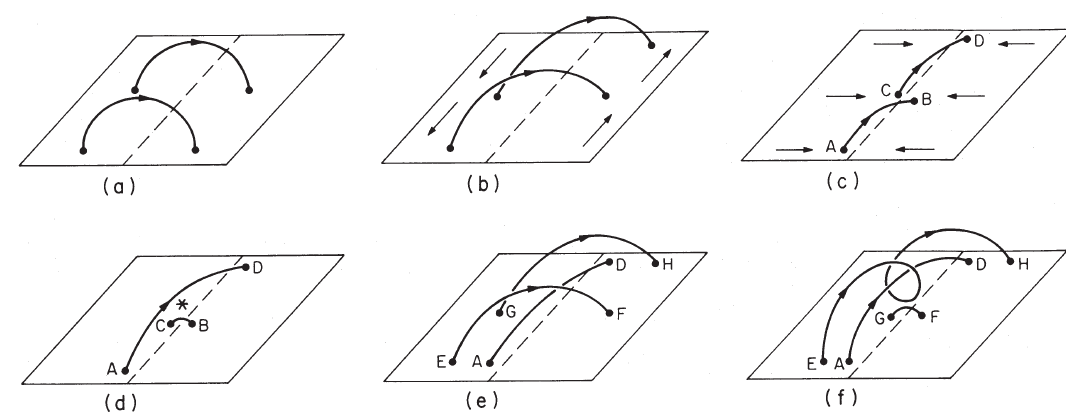
Figure 14: Flux cancellation scenario begins with converging opposite polarity magnetic flux fragments in a sheared arcade (panels a to c). Reconnection then produces a long loop (labelled AD in panel d) and a short loop (labelled CB in panel d) which then submerges. Overlying loops then converge and repeat the process (panels e to f). Image reproduced with permission from van Ballegooijen and Martens (1989), copyright by